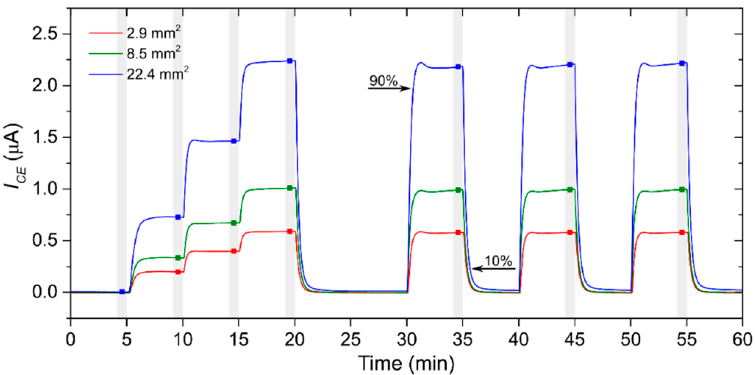
Figure 4. Sensor response to the test cycle for samples with different working electrode (WE) surface areas (conditions: 298 K, 40%RH (relative humidity), analyte flow rate 0.5 L/min).